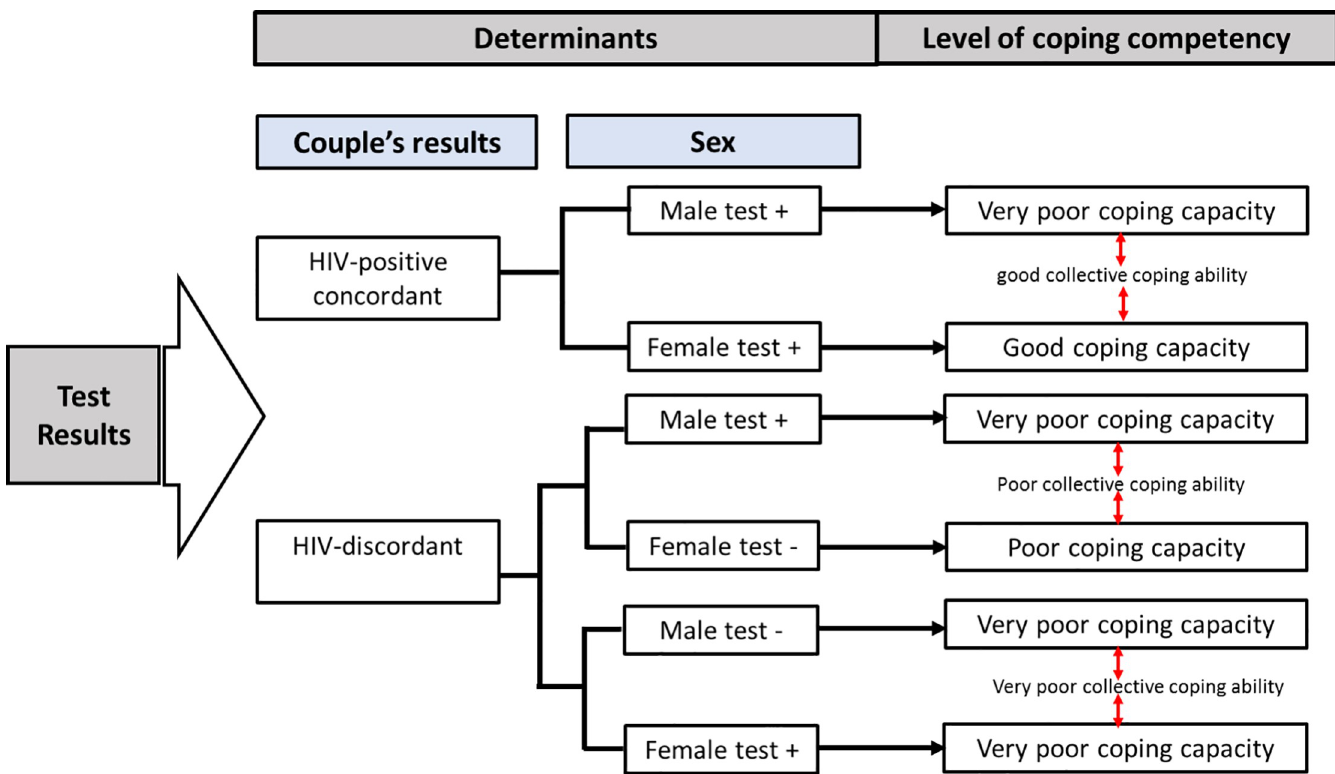
Fig 1. Individual and partners collective coping competency after HIV-positive and HIV-discordant test results. test + = test HIV-positive; test— = test HIV- negative.